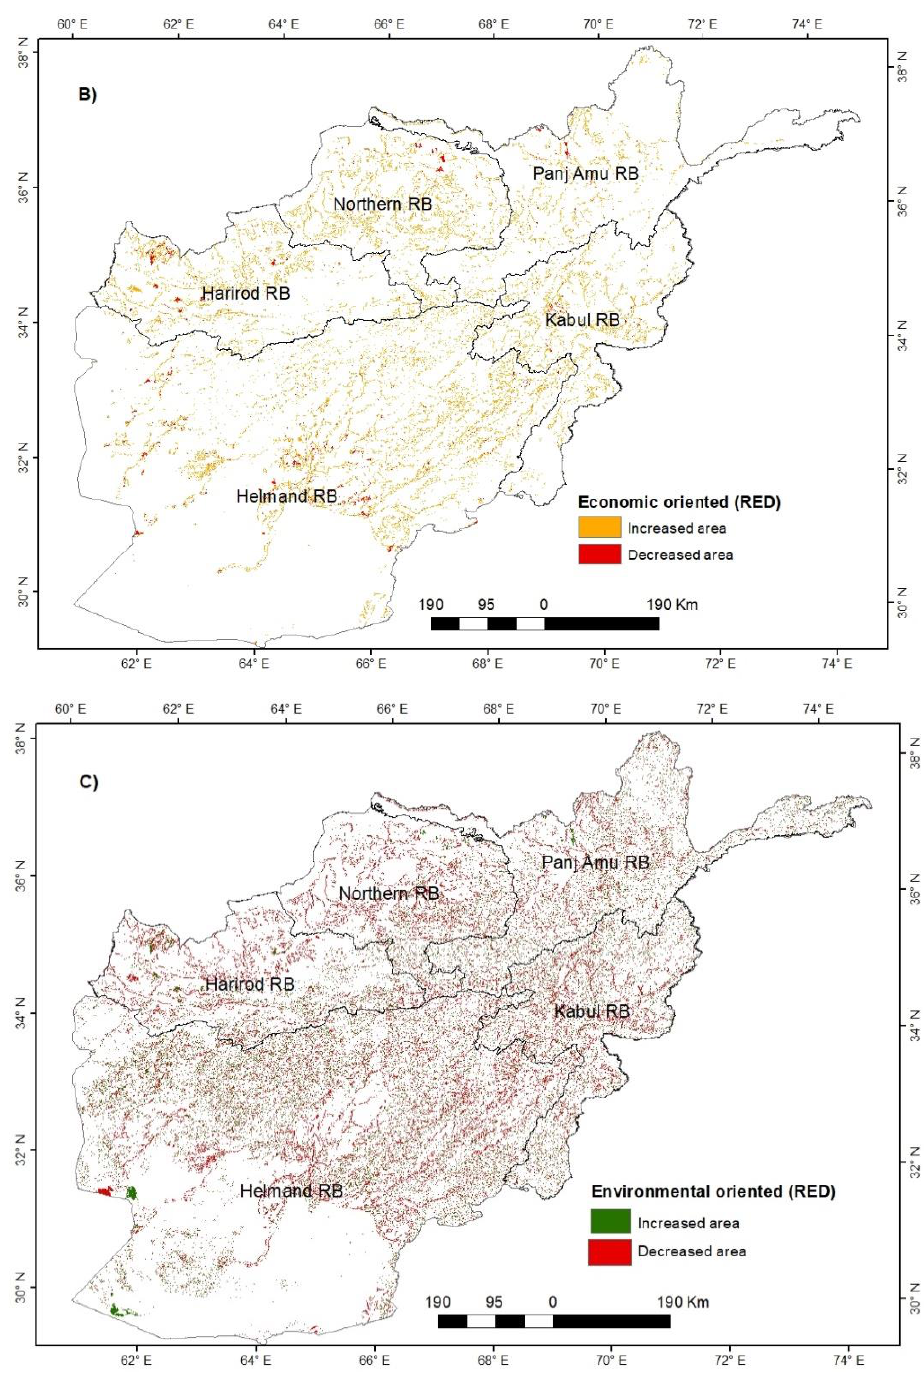
Figure 9. Spatial distribution of predicted LULC in 2030 under the RED scenario; ( A ) overall simulated LULC; ( B ) Simulated changes in economic-oriented LULC classes; ( C ) Simulated changes in environmental-oriented LULC classes.